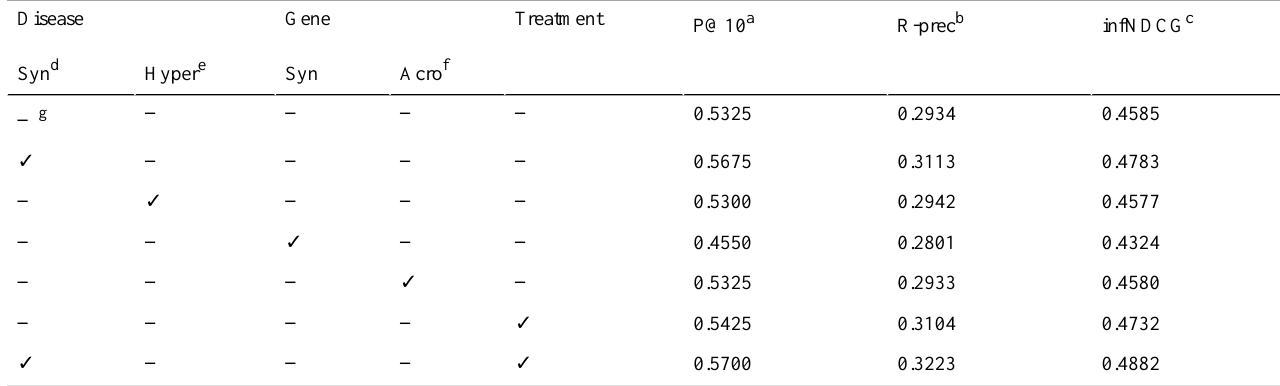
Table 2. Experimental results of query expansion.